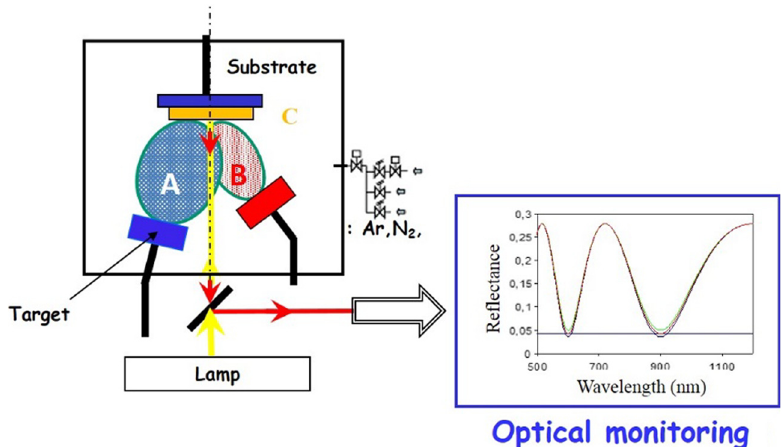
Fig. 1. Schematic illustration of the deposition system where target A is the glass-ceramic GC40 – 40 – 20 and target B is Sb 2 Se 3 :I. The set-up is equipped with an optical monitoring system by measuring the re fl ectance on substrate C, where the fi lm is deposited. The distance between target and substrate is to